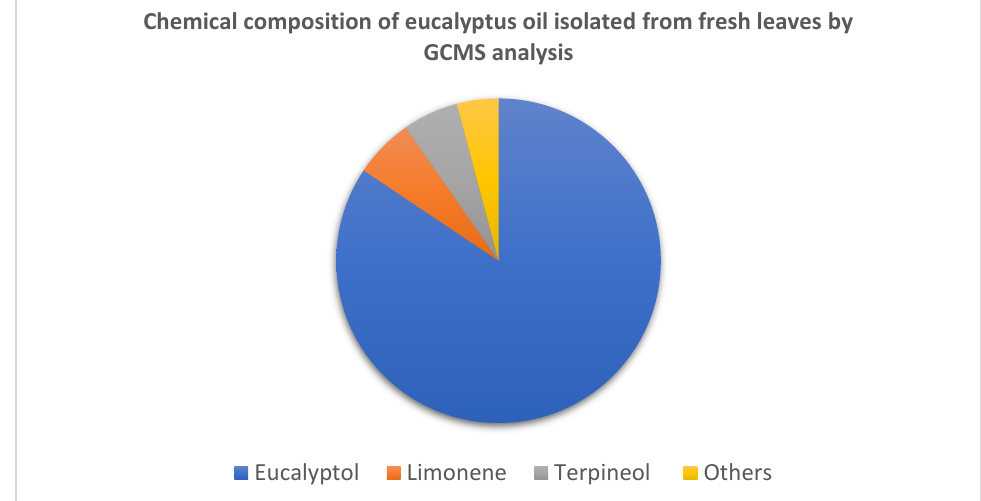
Figure 3. Chemical composition of eucalyptus oil.